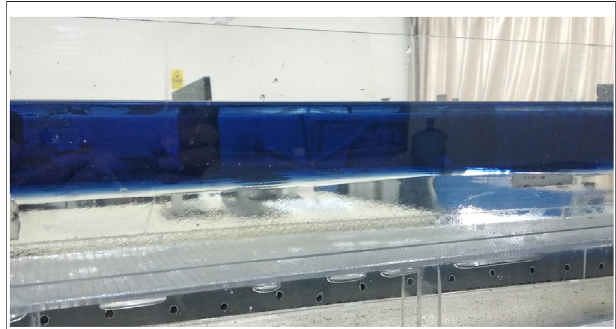
FIGURE 3 | Camera photo of the experimental fl ume to show the strati fi cation in the channel at the commencement of the fl ow for the case of Q S = 20 L/h, U 2 = 0.08 m/s, and ρ 0 = 1,060 kg/m 3 (case